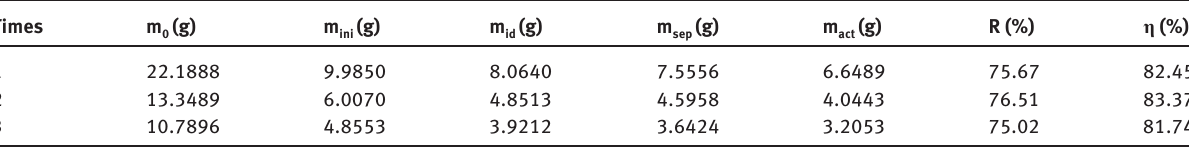
Table 2: Separation ratio and recovery ratio of refined Si for Al-45%Si alloy Times m 0